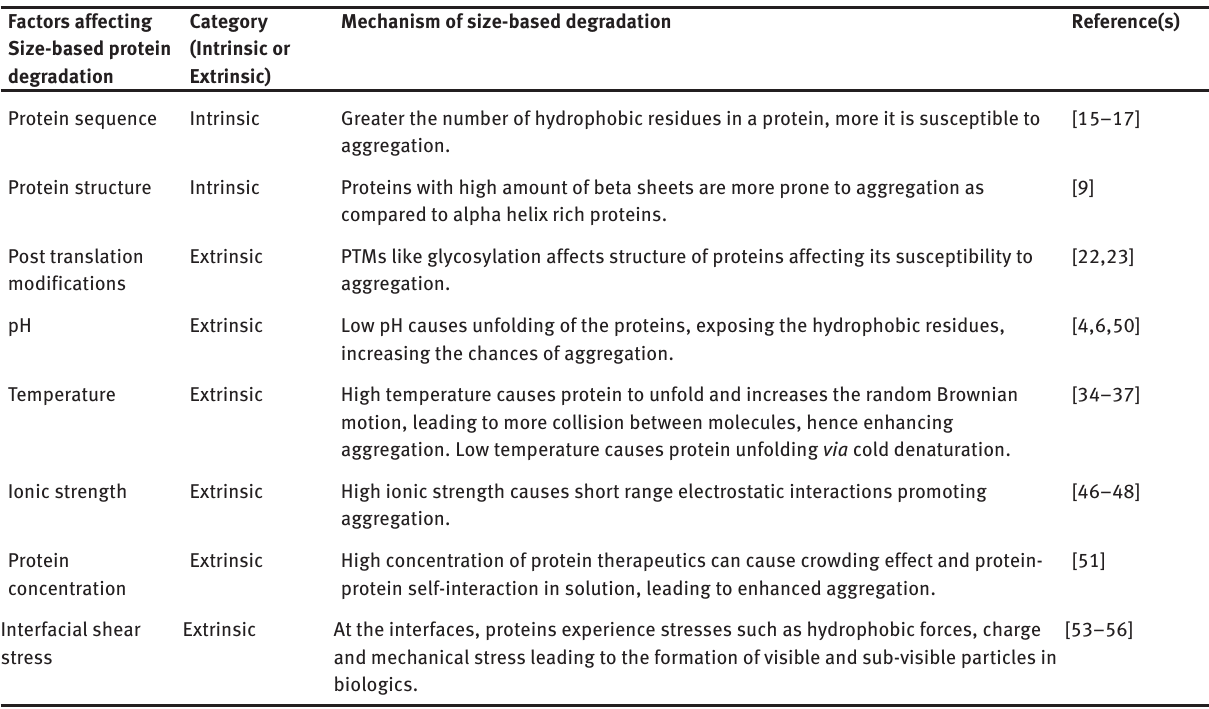
Table 1: Summary of the factors affecting size-based protein degradation. Factors